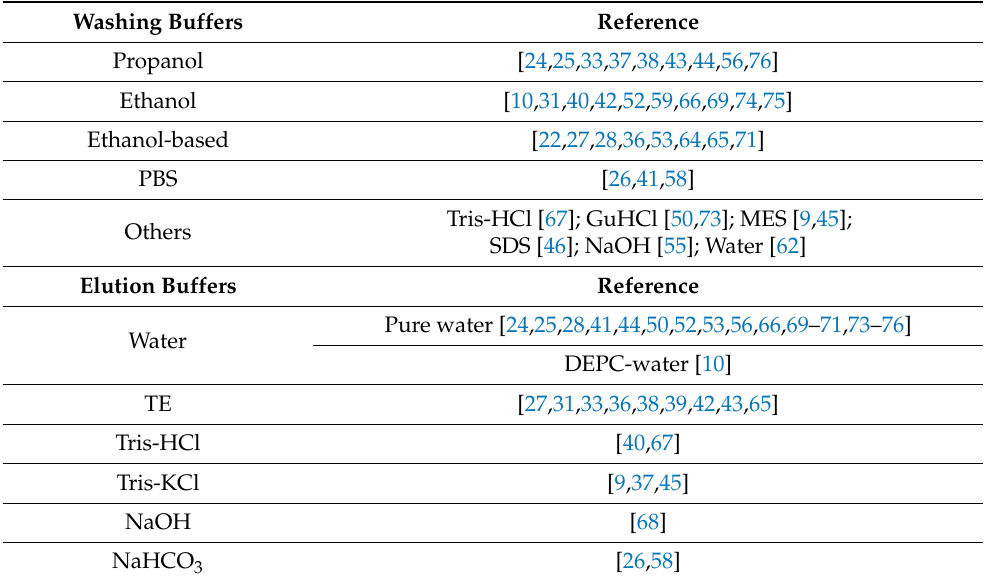
Table 3. Most used reagents for washing and elution steps in